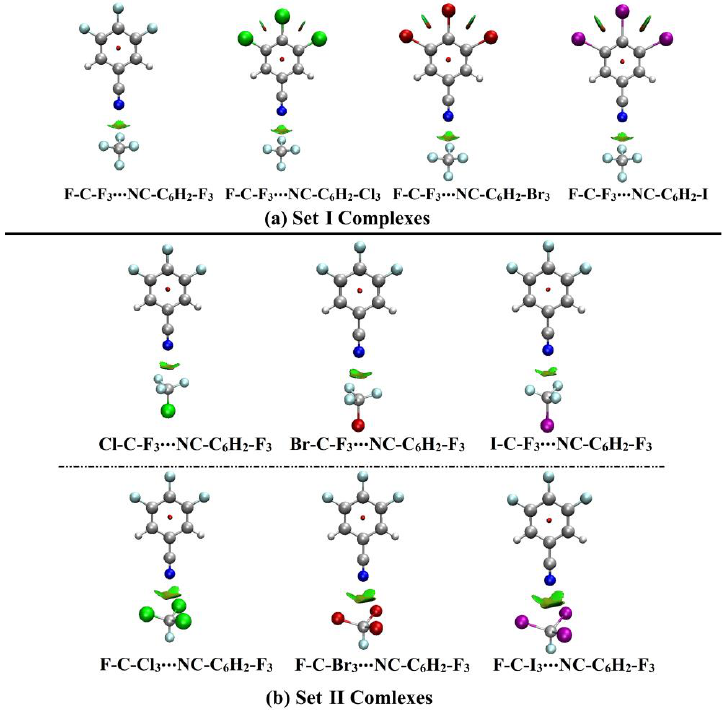
Figure 6. 3D NCI plots of the ( a ) Set I and ( b ) Set II complexes. The color range extended based on the sign(λ 2 ) ρ from − 0.035 to 0.020 au (blue to red).